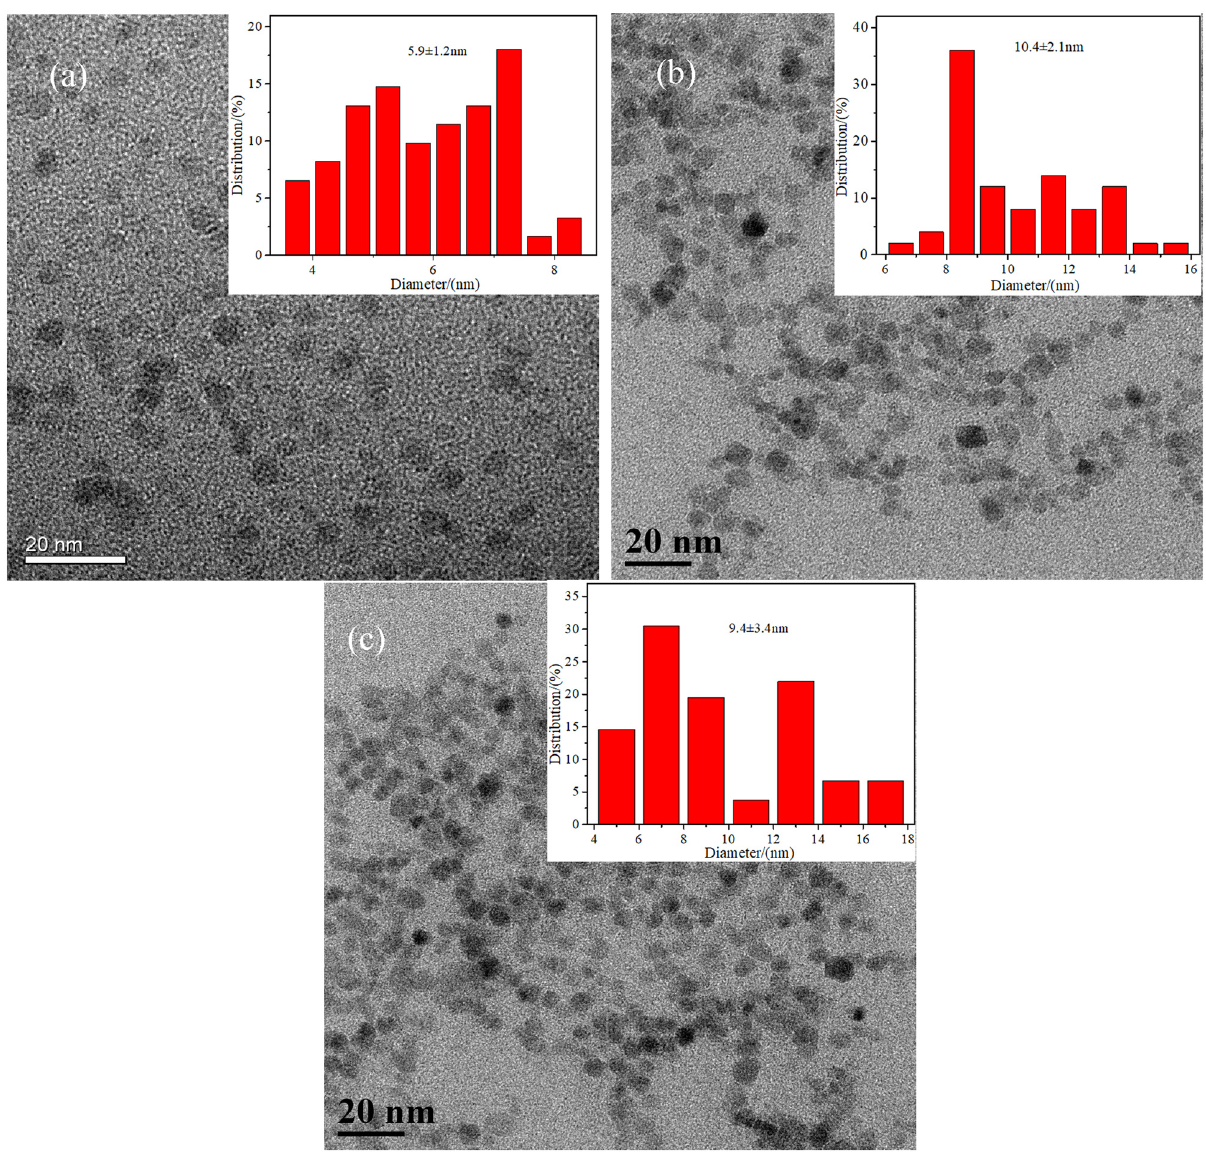
Figure 2: TEM images of Fe 3 O 4 @DDT - PMAA MF at ( a ) 0.5% of DDT - PMAA; ( b ) 1% of DDT - PMAA; and ( c ) 2% of DDT - PMAA, the scale bars are all in 20